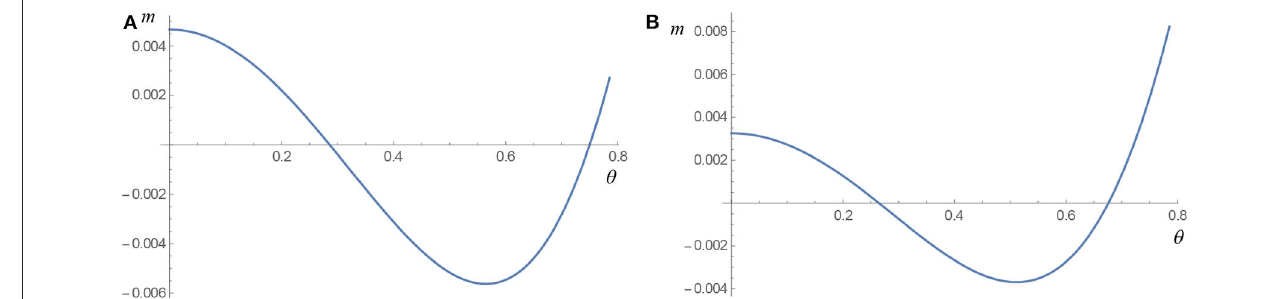
FIGURE 2 | Dimensionless moment m versus colatitude θ for β = π /4 and µ = 1: (A) k = 5; (B) k = 500.